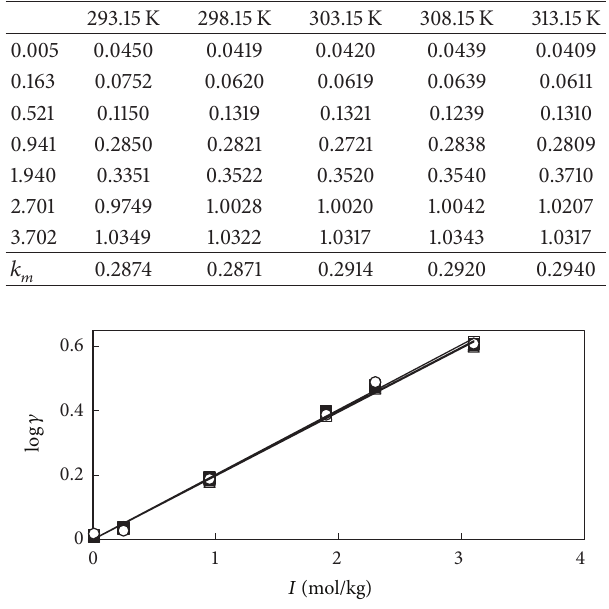
Figure 3: Dependence of log 𝛾 on ionic strength in KCl for 1- naphthol at 293.15 K( 󳵻 ),298.15 K( 󳵳 ),303.15 K( ◻ ),308.15 K( ◼ ),and 313.15 K ( I